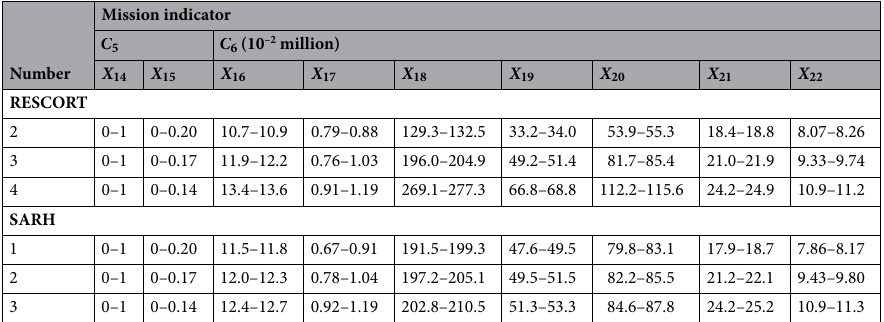
Table 6. Indicators X 14 ∼ X 22 and their value ranges. X 14 -number of pieces of equipment destroyed on our side, X 15 -rate of equipment damaged on our side, X 16 -fuel consumption cost of cruising phase, X 17 -fuel consumption cost of returning phase, X 18 -depreciation of airframe, X 19 -maintenance fee, X 20 -insurance premium, X 21 -cost of pilot utilization, X 22 -cost of ground crew utilization. In addition, the indicators with small variation intervals or take essentially constant values would not be listed in this paper.